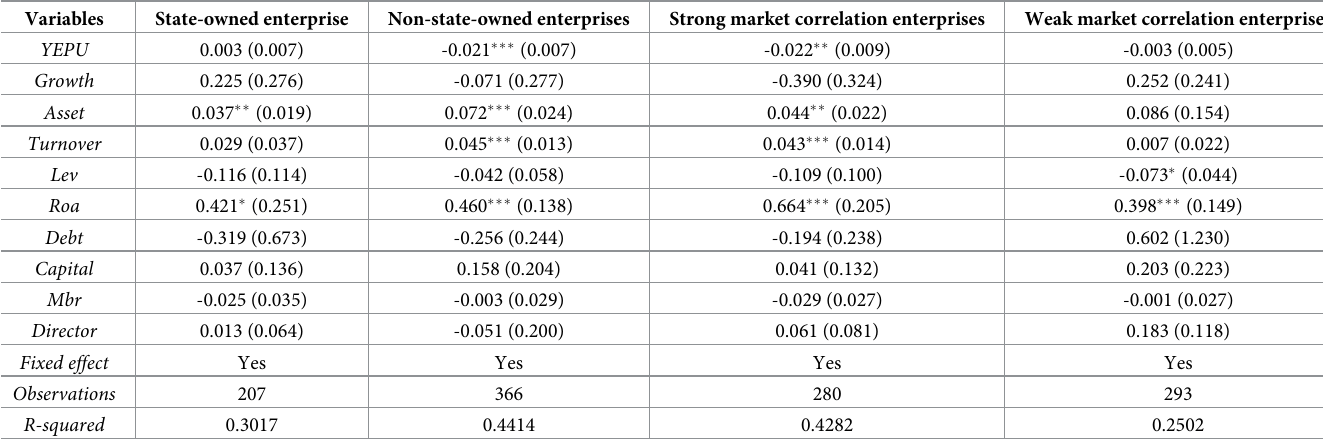
Table 4. Results of the group